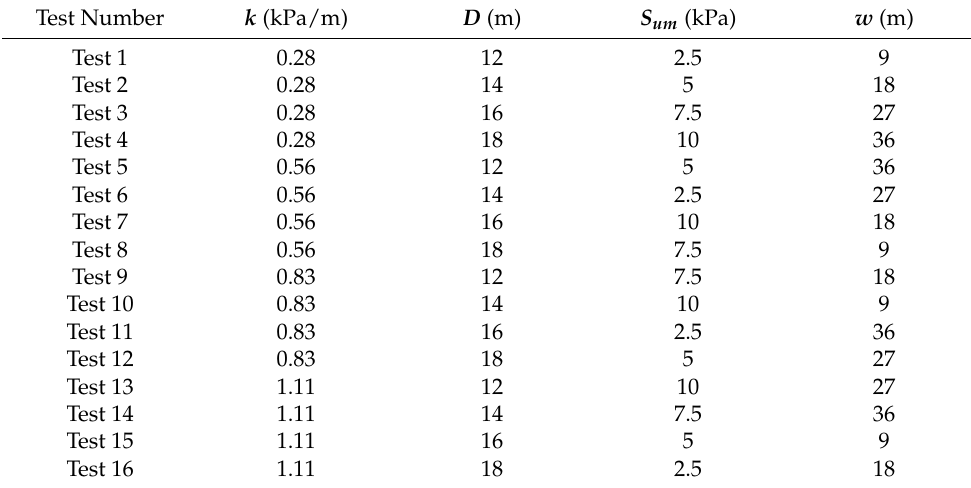
Table 4. Orthogonal experimental design.